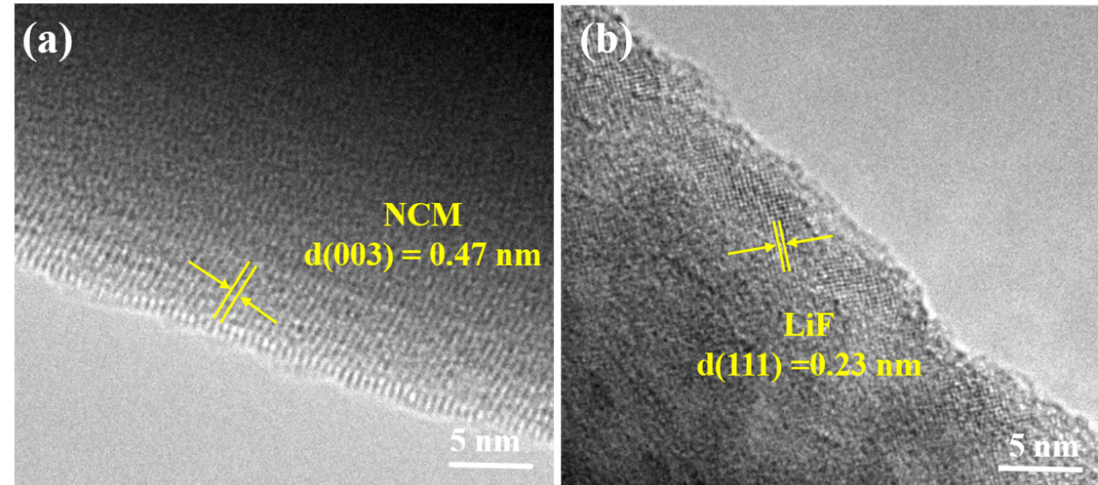
Figure 5. HRTEM images of ( a ) 0%LiF@NCM and ( b ) 1%LiF@NCM.